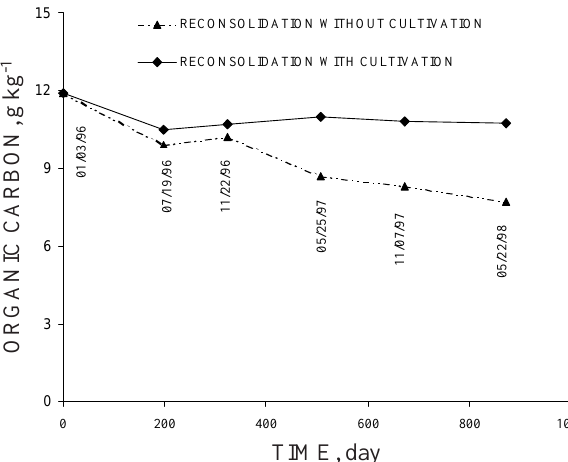
Figure 1. Organic carbon at a soil depth of 0-0.10 m as a function of time in the reconsolidating soil